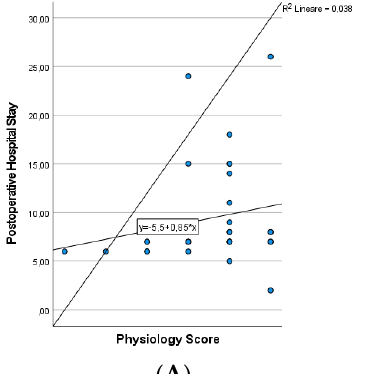
Figure 1. Pearson correlation coefficient to predict postoperative hospital stay. Physiology Score and Postoperative Hospital Stay ( ρ = 0.193 p value = 0.289). Operative Severity Score and Postoperative Hospital Stay ( ρ = 0.07 p value = 0.703). Mortality Rate and Postoperative Hospital Stay ( ρ = 0.269 p value = 0.136).